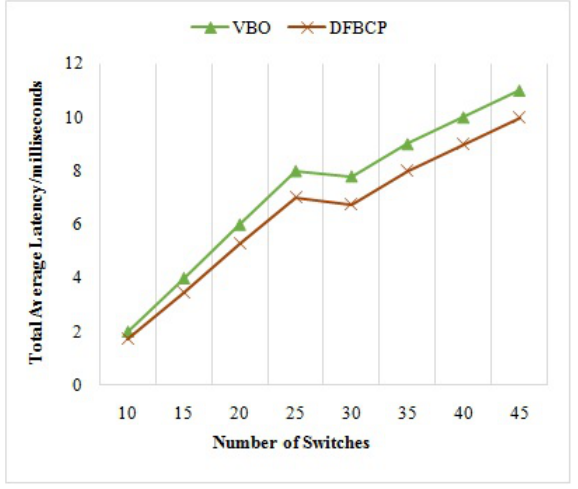
Figure 8. Convergence plots for uncapacitated controller placement problem for EU-GÉANT. Figure 9 has the convergence plots for the controller placement problem for the capac- itated scenario when used in an Internet2 OS3E topology. DFBCP SDN outperformed the VBO by 10%. Figure 10 has the convergence plots for the capacitated controller placement problem for EU-GÉANT topology. DFBCP SDN outperformed the VBO by 8%.